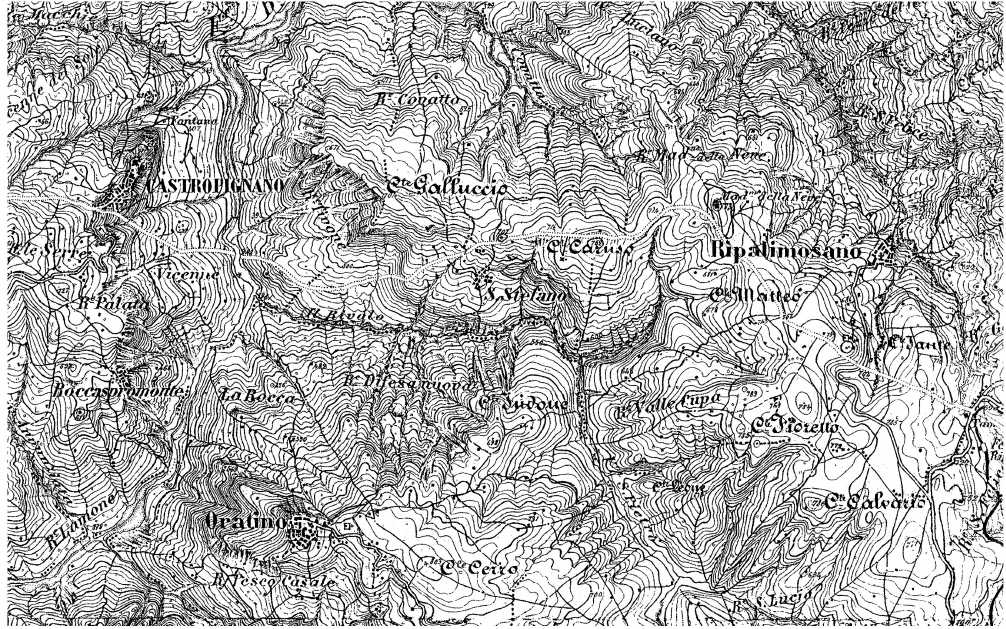
Figure A2. Details of sheet 1:50,000, it is possible to recognize the tratturo’s boundaries represented by two dotted lines. In particular, it can be noticeable above the toponym C. Caruso. The tratturo’s width is not drawn with the same scale of the map. Authorization to publish n. 6959 of 2017.10.03 granted by Istituto Geografico Militare Italiano